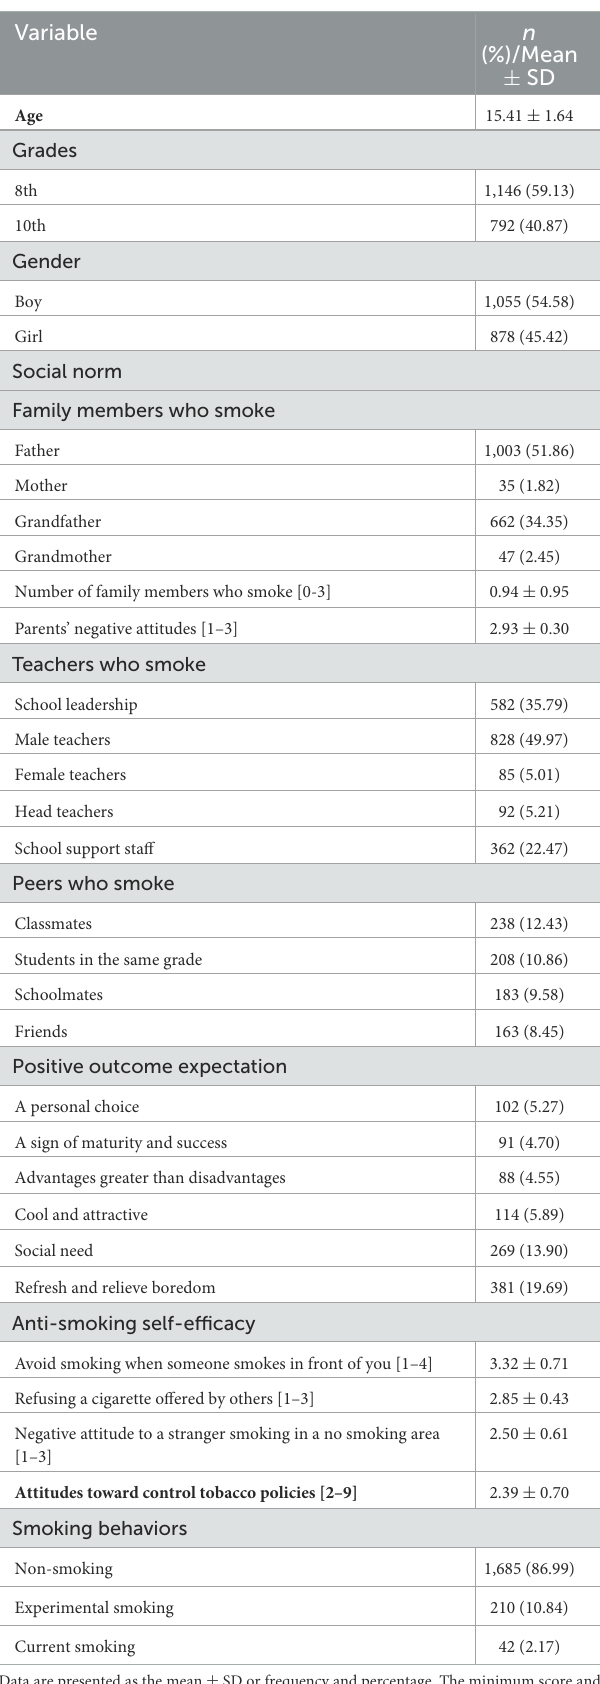
TABLE 1 Characteristics of the study sample in Huli District, Xiamen, China ( n = 1,937).